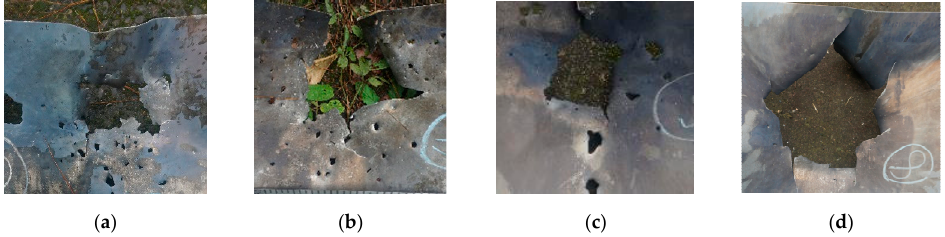
Figure 13. Damage on the front side of the aluminum target plate: ( a ) No. 3, ( b ) No. 4, ( c ) No. 5, and ( d ) No. 8.